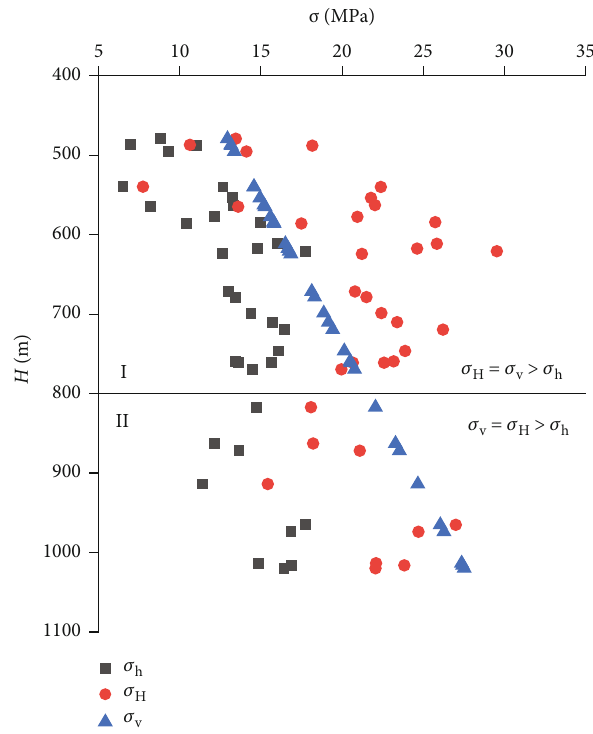
Figure 6: Scatter diagrams of maximum horizontal principle stress, minimum horizontal principle stress, vertical stress, and burial depth (I represents dynamic fi eld; II represents static stress fi